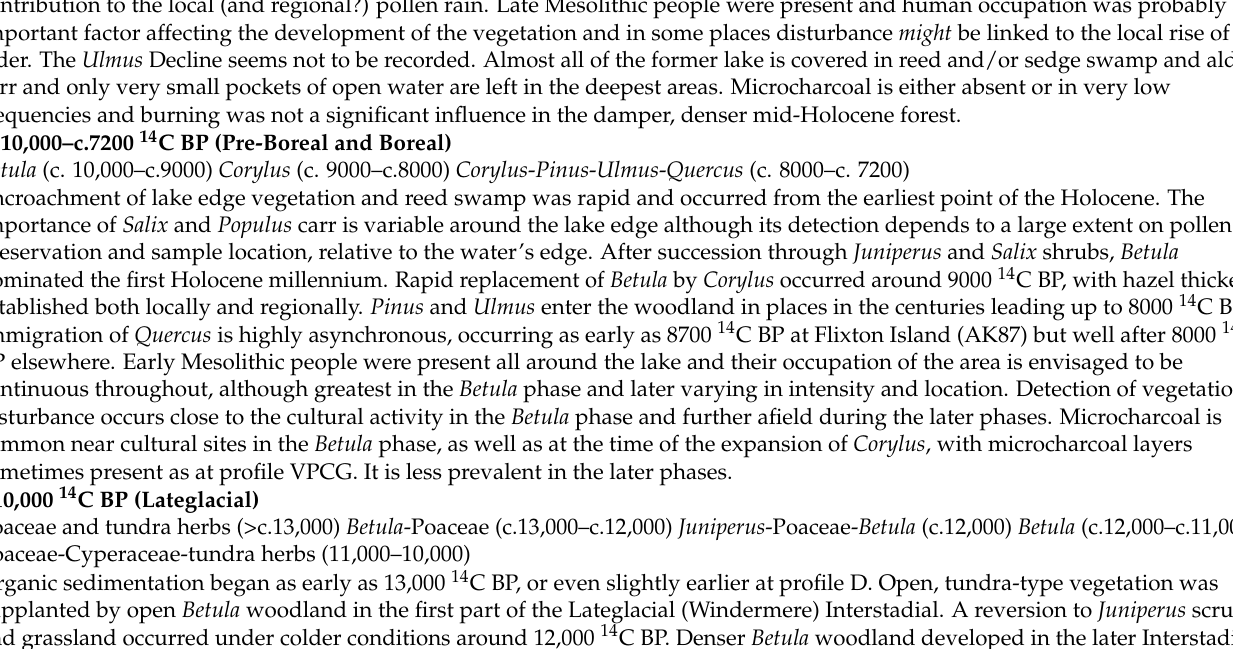
Table 3. Synopsis of major vegetation changes and palaeoenvironmental history. Most of the ages for the immigration of the major trees are strongly asynchronous. Quoted ages are in radiocarbon